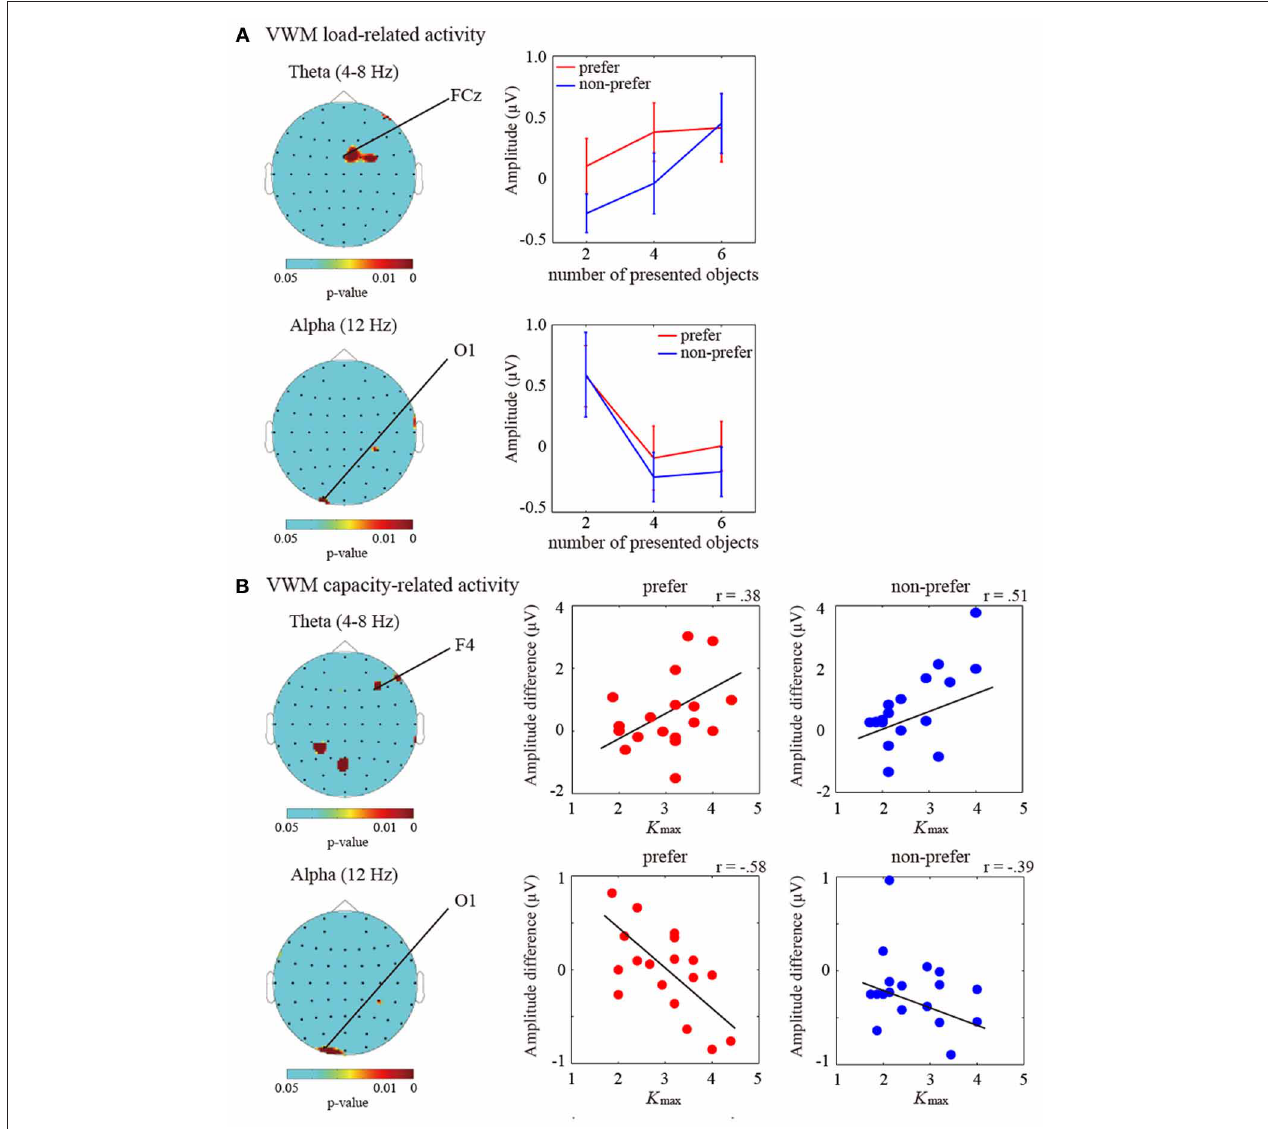
FIGURE 2 | (A) (Left) Statistical topographic colored scalp maps of the theta (4–8Hz; top panel) and alpha (12Hz; bottom panel) delay-period activation showing p-values for the main effects of number of objects on ANOVA ( P < 0 . 05). The drawing shows the top view of the scalp. (Right) Bar graph showing the subject-averaged amplitude of theta frequency bands at the frontal (FCz) electrode and alpha frequency bands at the occipital (O1) electrode under the “preferred” (red) and “non-preferred”(blue) conditions. Error bars represent standard errors of the mean. (B) (Left) Statistical